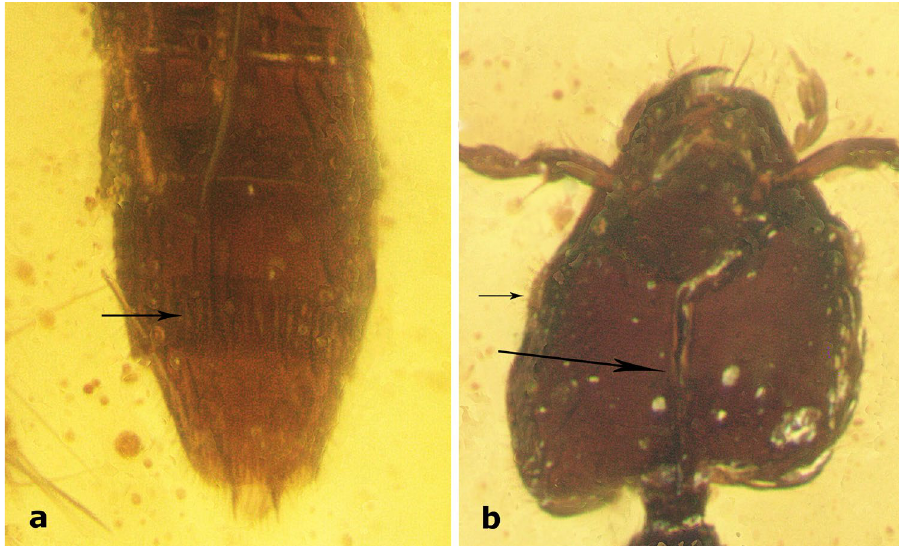
Figure 5. Midinudon juvenis gen. and sp. nov., photos of paratype, collection number. GPIH05516. (a) Apex of abdomen, ventral view, line of setae on sternite VII marked with an arrow. (b) Head, dorsal view, large arrow: stem of Y-shaped suture, small arrow: setae between